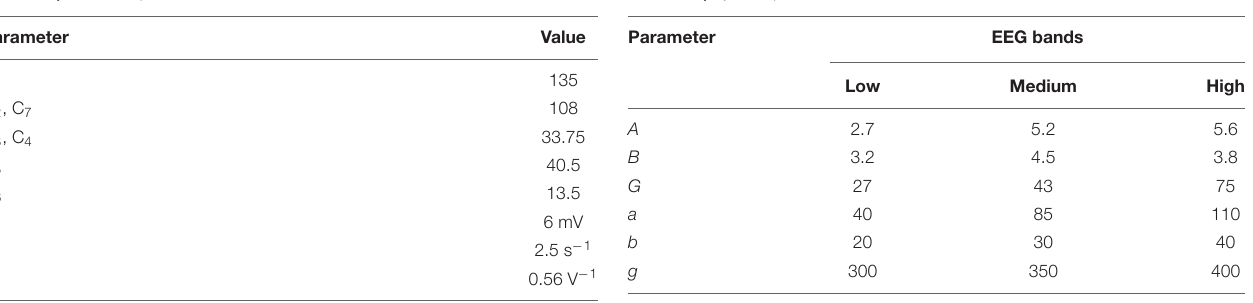
TABLE 4 | Comman parameters in NMM. TABLE 5 | System parameters in NMM for different EEG